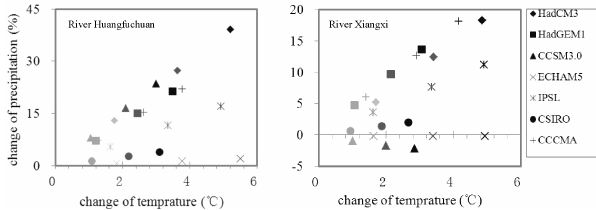
Figure 2. Scatter plots of annual temperature and precipitation changes for seven GCM projections for the 2020s, 2050s and 2080s time horizons for the rivers Huangfuchuan and Xiangxi (compared to the 1961–1990 baseline; 2020s: light grey; 2050s: dark grey; 2080s: